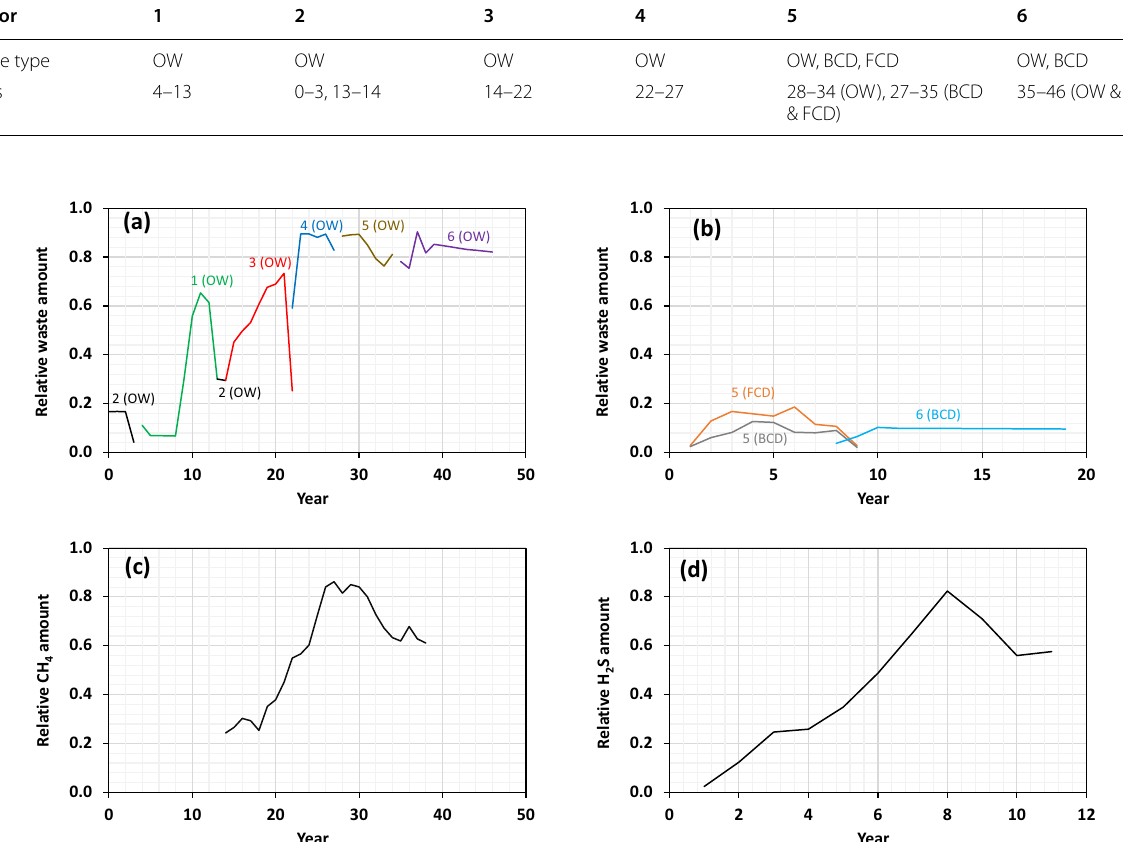
Fig. 1 a Landfilled waste (OW) from sectors 1, 2, 3, 4, 5, and 6, b Landfilled waste (BCD and FCD) from sectors 5 and 6, c Measured CH 4 from all the sectors, and d Measured H 2 S from sectors 5 and 6, all in relative values due to data